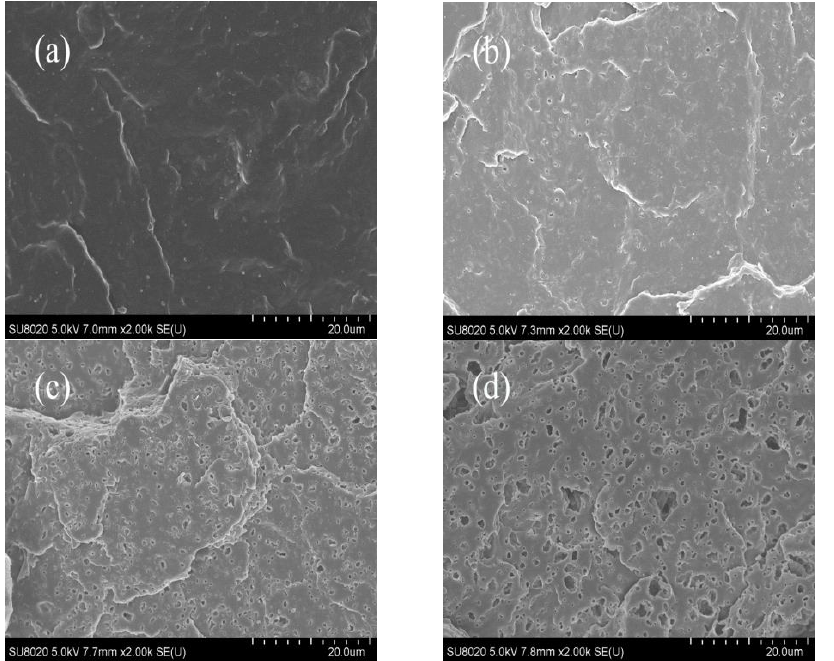
Figure 4. SEM images of Ac-SEBS/PP blends with different acetylation degrees of SEBS: ( a ): PP; ( b ): 0%; ( c ): 4.6%; ( d ): 12%.